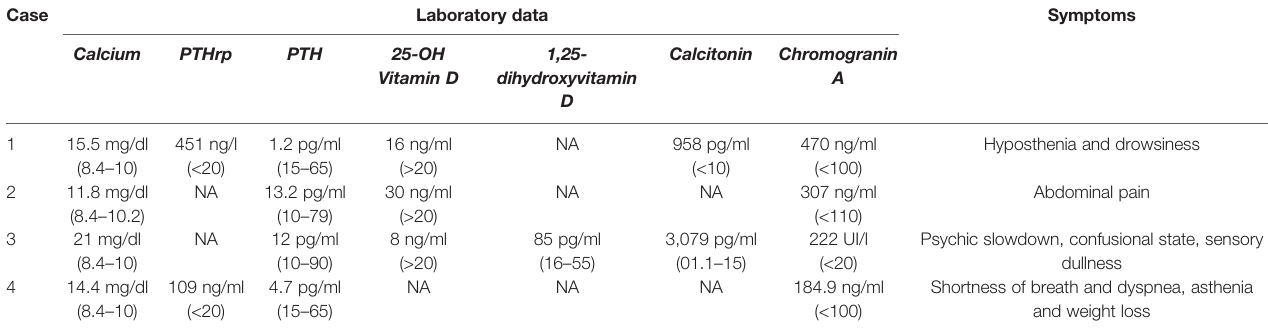
TABLE 1 | Summary of laboratory data and clinical presentation of the four cases at paraneoplastic hypercalcemia diagnosis. Case Laboratory